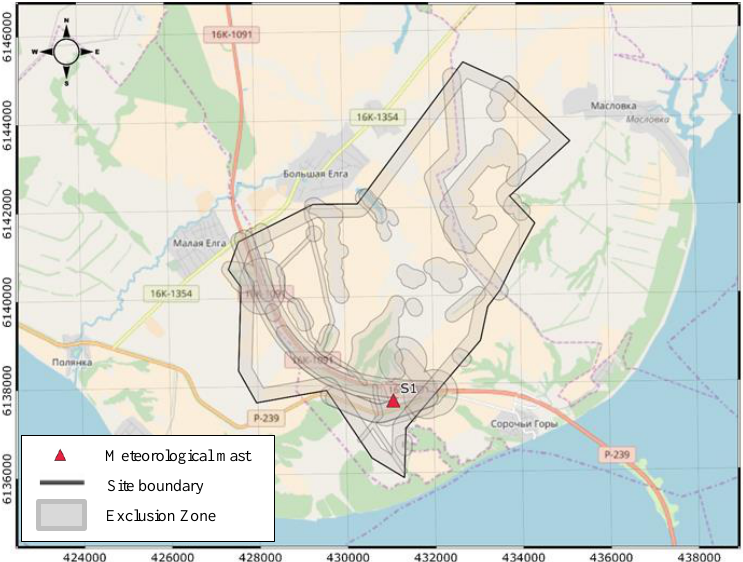
Figure 10. Excluded zones and allowed area for placing wind turbines at the Sorochi Gory Wind Farm site